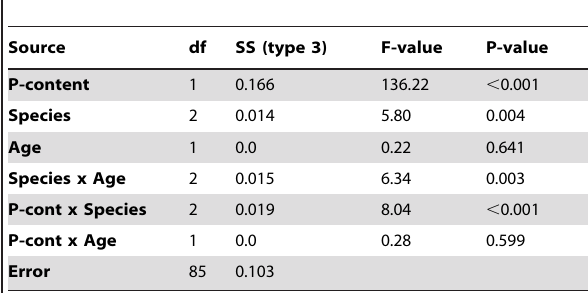
Table 2. Results of ANCOVA for the effects of Daphnia body P-content and age (4-day-old juveniles, mature adults) on specific growth rates (GR) of D. magna, D. pulicaria and D. galeata x hyalina .